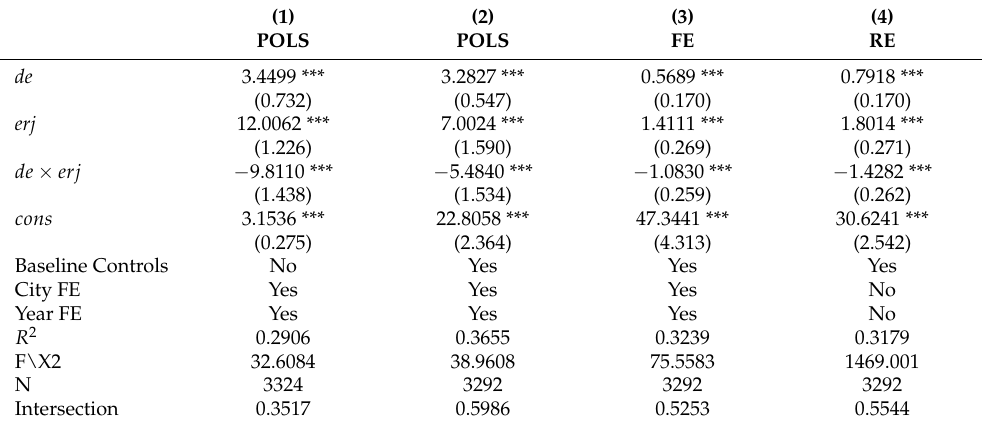
Table 10. Robustness Test I: Substitution of elasticity estimates of output between areas.